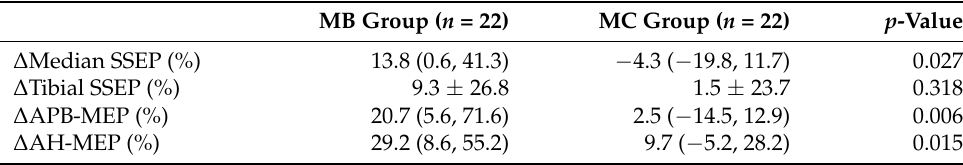
Table 2. Changes in the amplitude of each evoked potential during